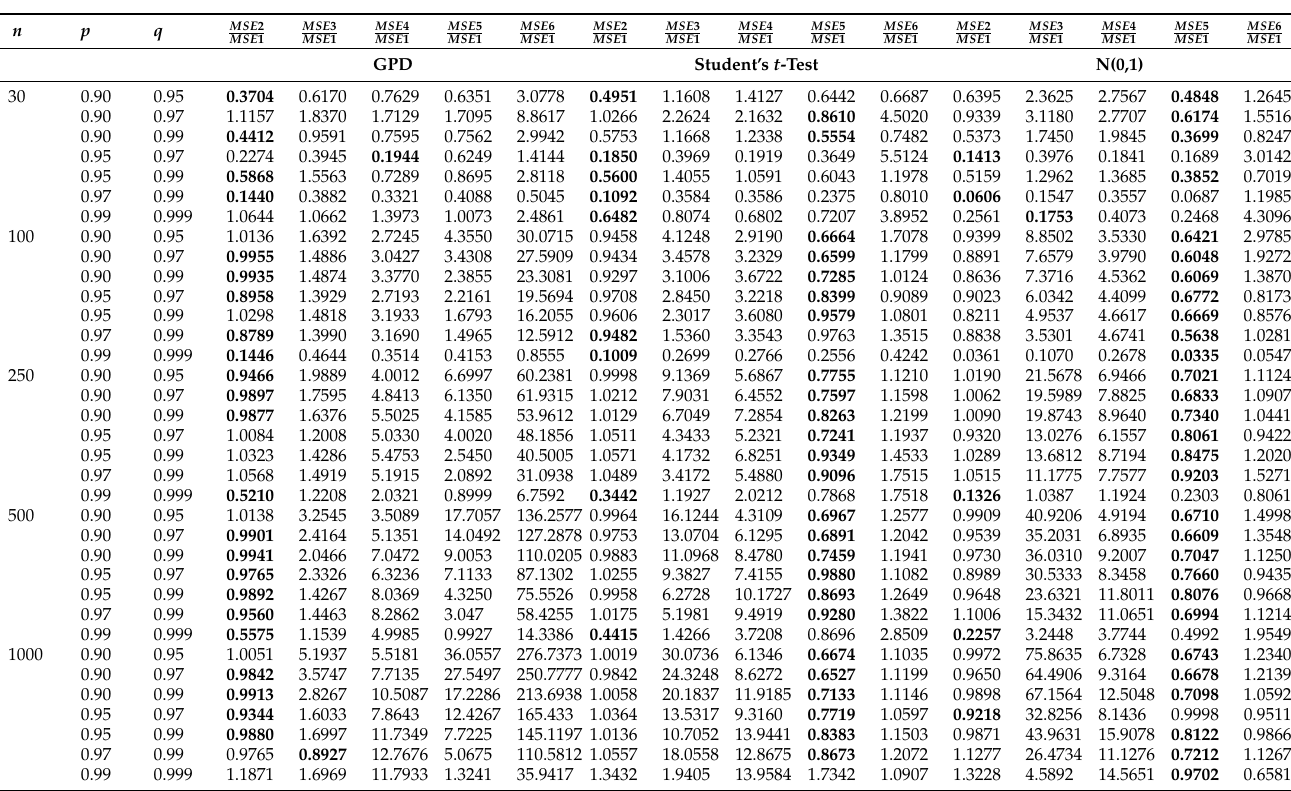
Table 1. Ratios estimated for iid cases with varying p and q